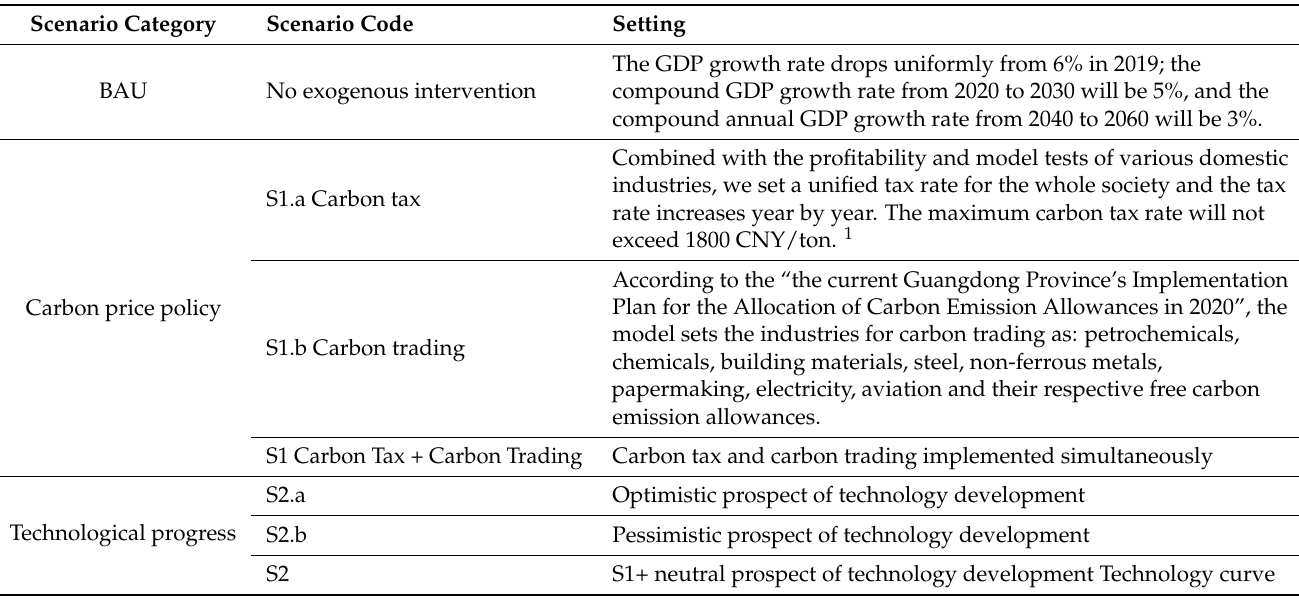
Table 2. Scenario